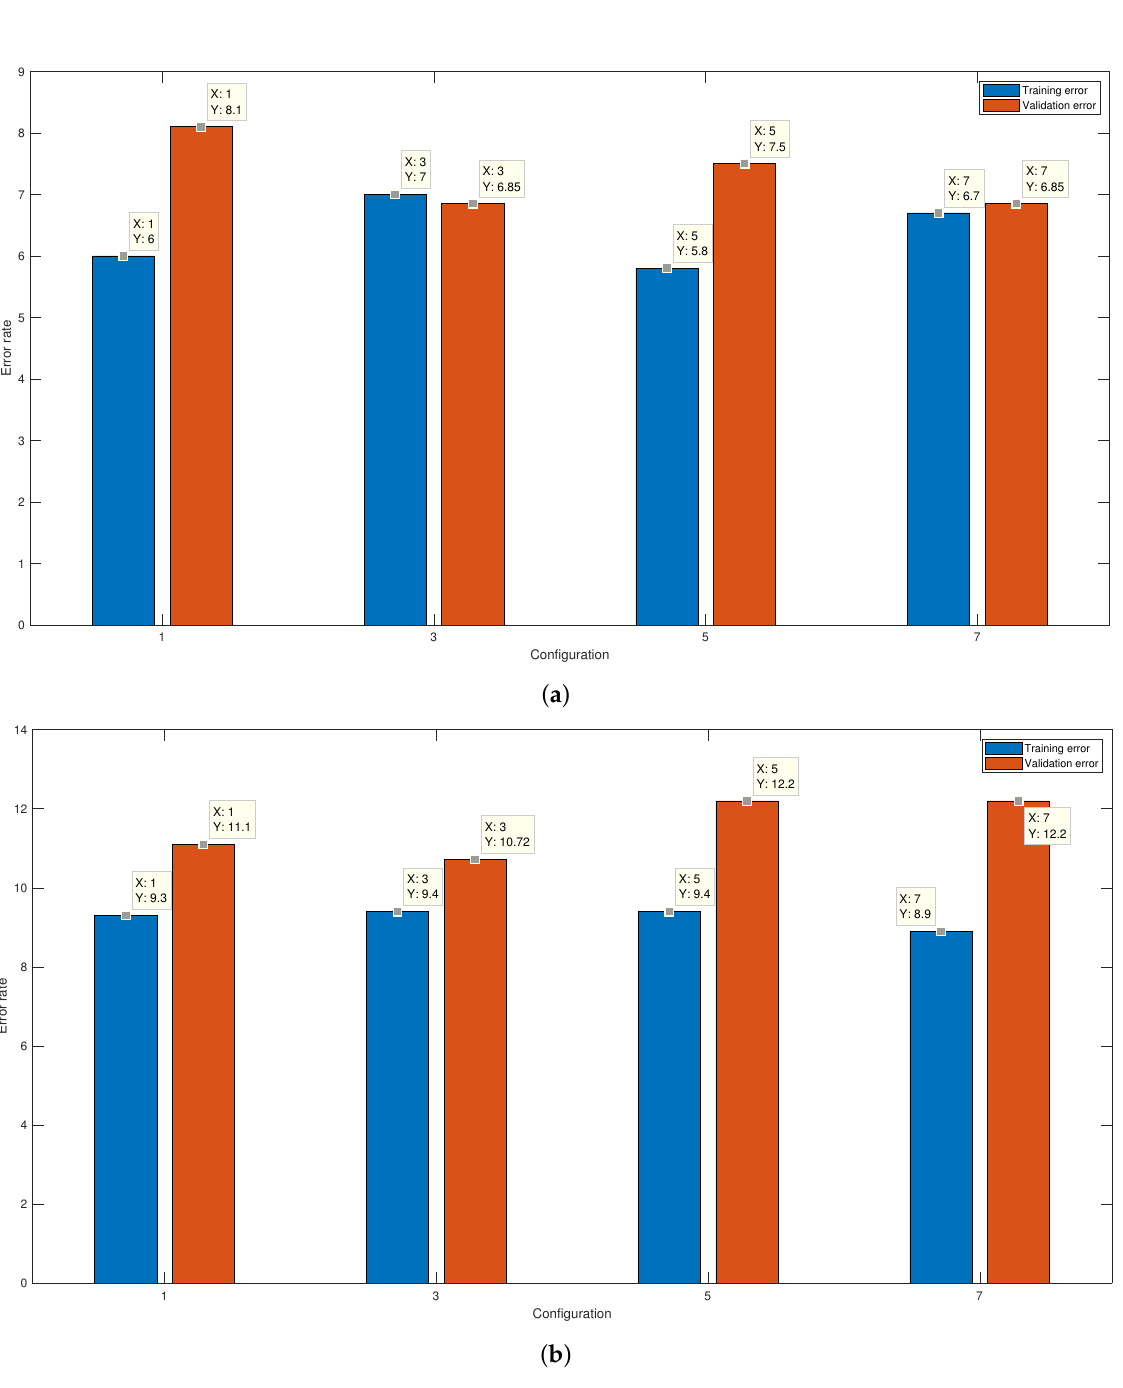
Figure 12. Results of the average error percentage for the training and validation of the final SVM with ( a ) Gaussian kernel and with a ( b ) Linear